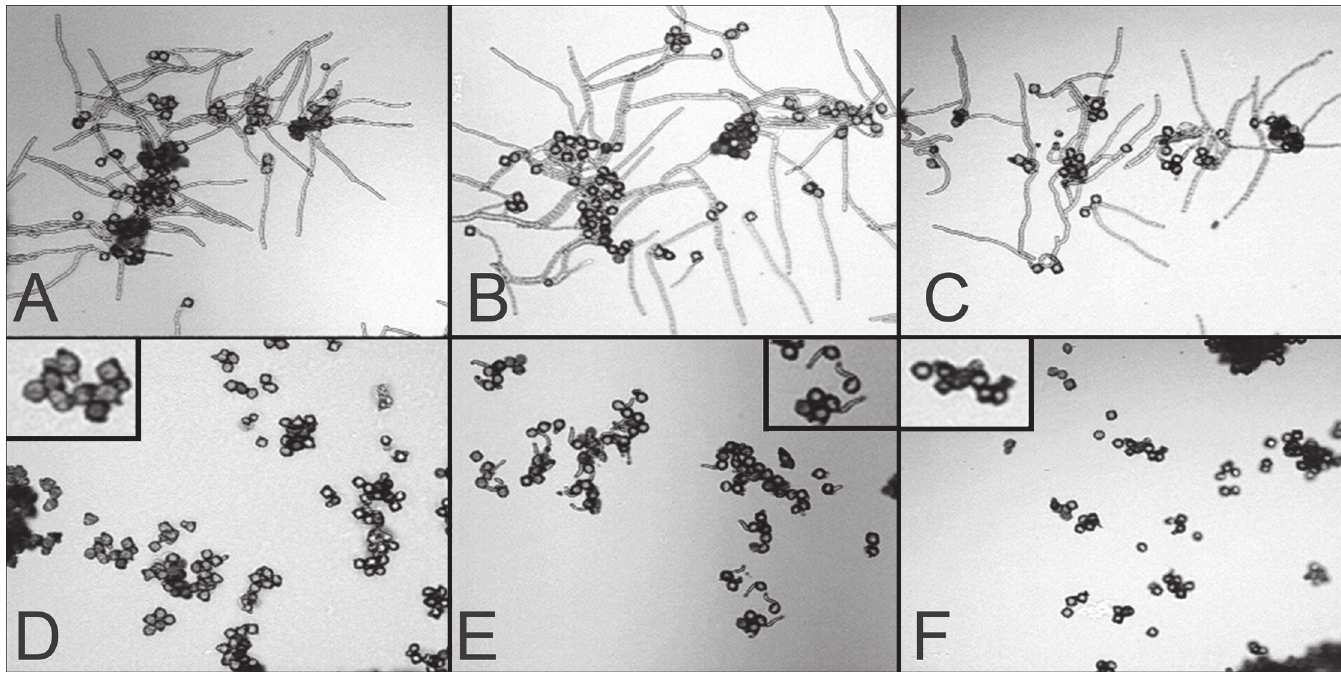
Fig 5. Photomicrographs of tobacco pollen following a high temperature challenge. SR1 (A), SR1-GS2 (B), and SR1-GS3 (C) tobacco pollen germination when incubated at 30°C for 3 hours; and SR1 (D), SR1-GS2 (E), SR1-GS3 (F) pollen germination when incubated at 46°C for 3 hours.